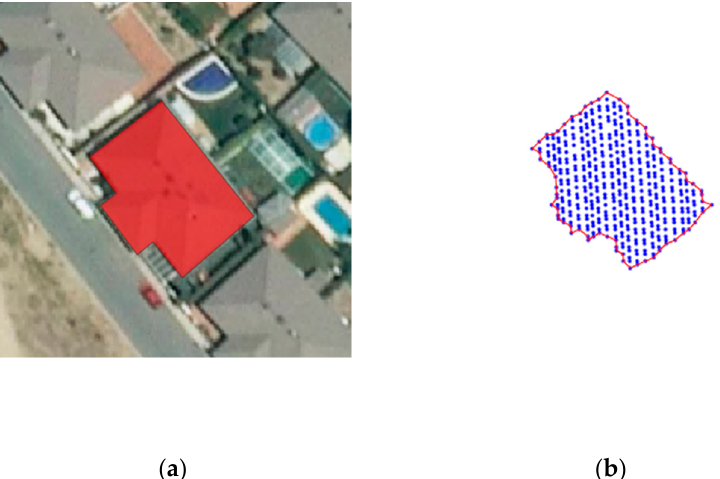
Figure 3. Point cloud filtering process: ( a ) original, ( b ) after removing points belonging to the ground, ( c ) after removing points belonging to vegetation areas, ( d ) after removing points belonging to building façades, ( e ) after removing noise points.